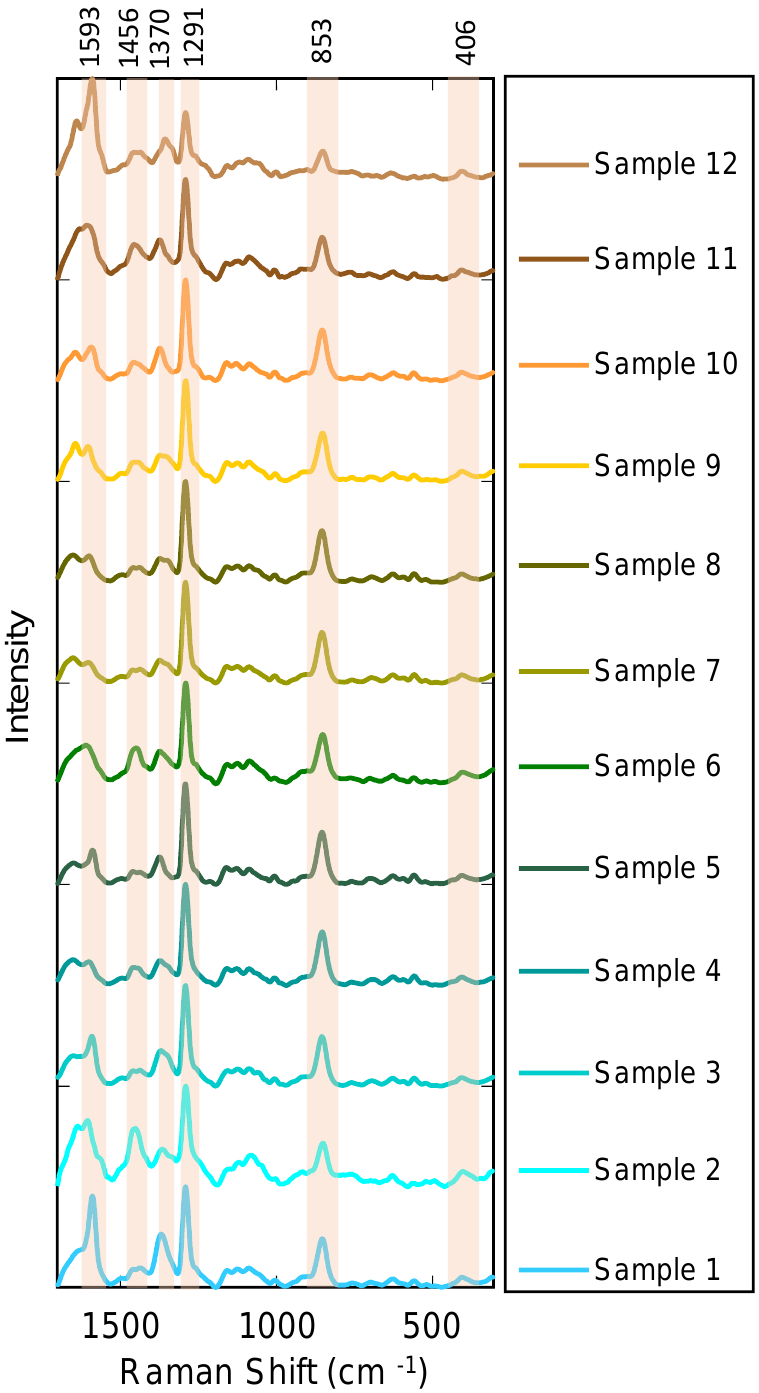
Figure 2. Averaged preprocessed Raman spectra of all smokeless powder sample classes. Important Raman peaks are highlighted and labeled.